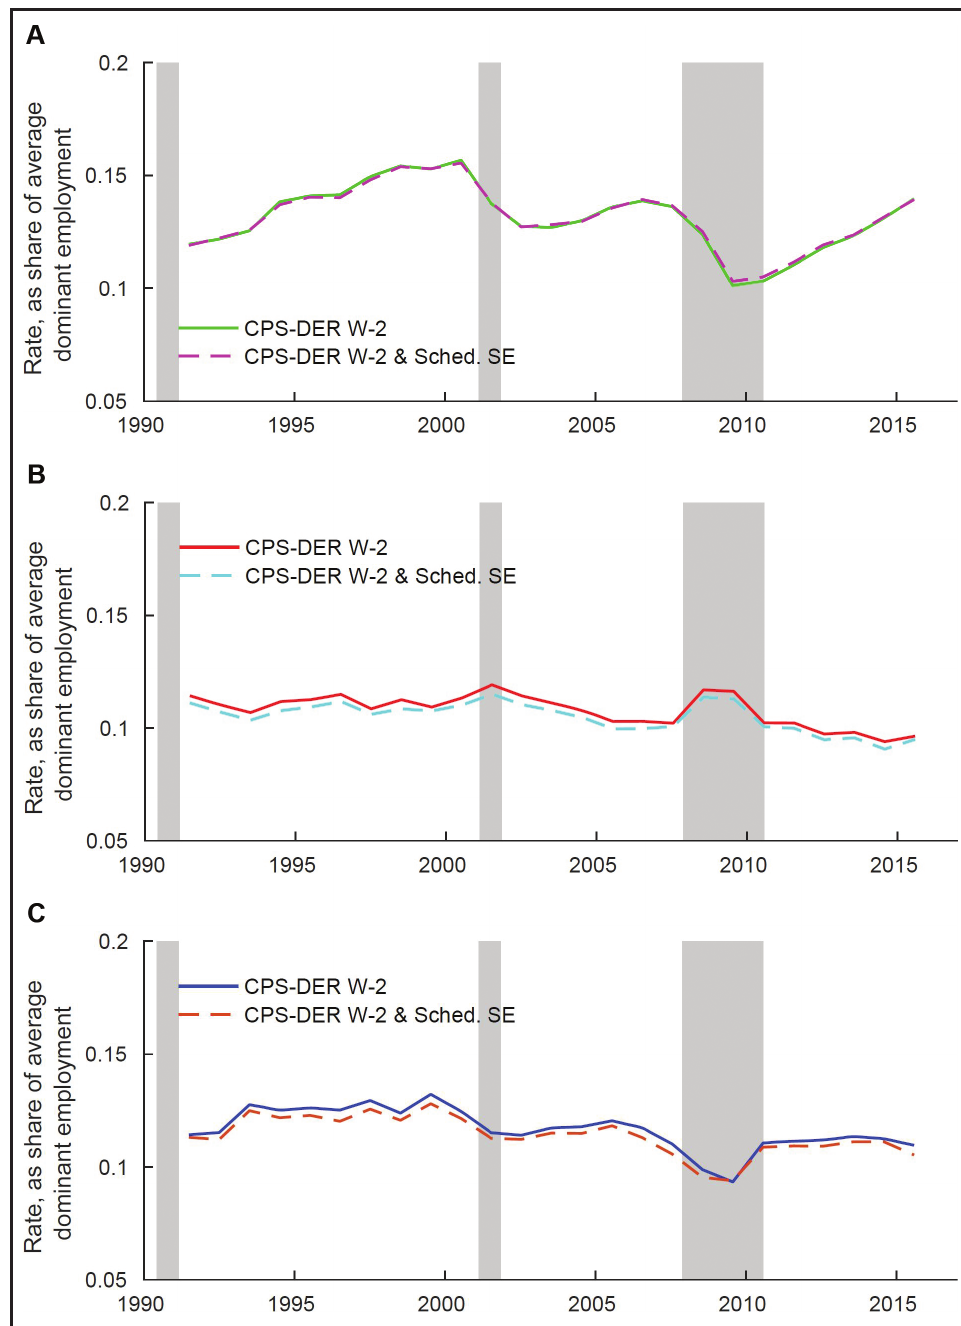
Figure 4 Employer-to-employer and nonemployment